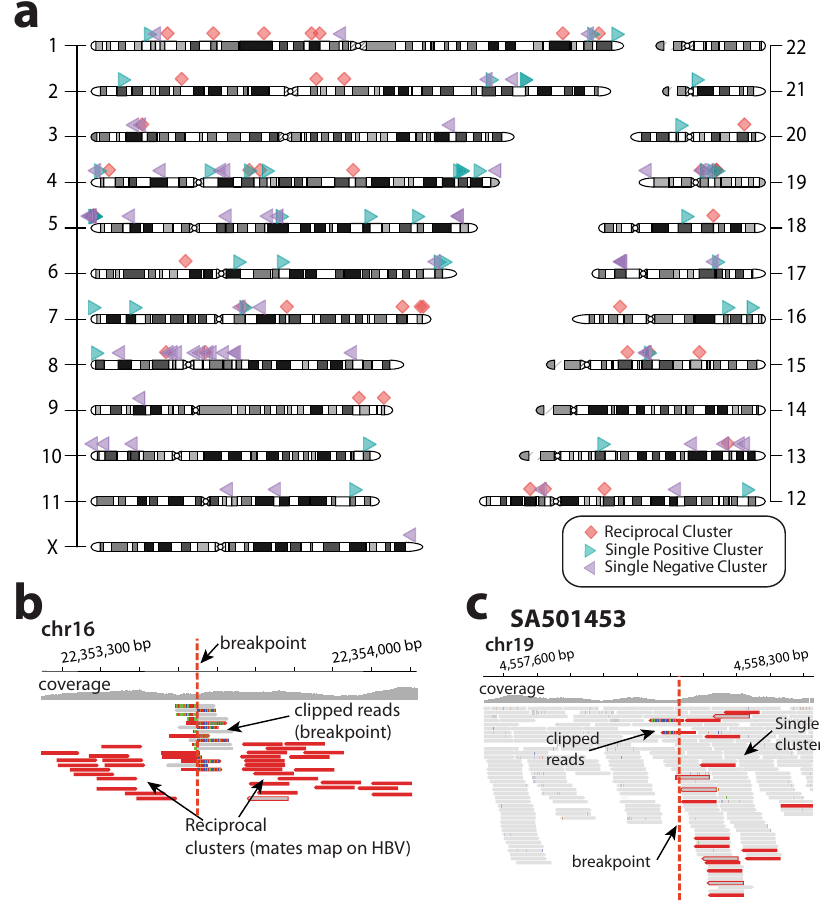
Fig. 1 The landscape of HBV insertions in 296 HCCs from the PCAWG dataset. a Canonical (reciprocal) insertions are represented as red diamonds, and non-canonical insertions (single-clusters) as purple and green triangles for positive and negative clusters, respectively. In total, 148 integration events are shown of which 72% represent non-canonical events. b Classical pattern of canonical HBV insertions identi fi ed with Illumina paired-end mapping data is characterised by two reciprocal clusters of discordant reads, and clipped reads, in face-to-face orientation, demarcating the boundaries of the genomic integration. The mates of these reads map onto HBV consensus sequences. Clipped reads span the insertion site allowing base-pair resolution of the insertion breakpoints. c Most HBV insertion events in HCC tumours show a non-canonical pattern in which a single cluster of paired-end reads (short- reads in red) demarcates one of the two boundaries of the insertion only, while the second cluster is